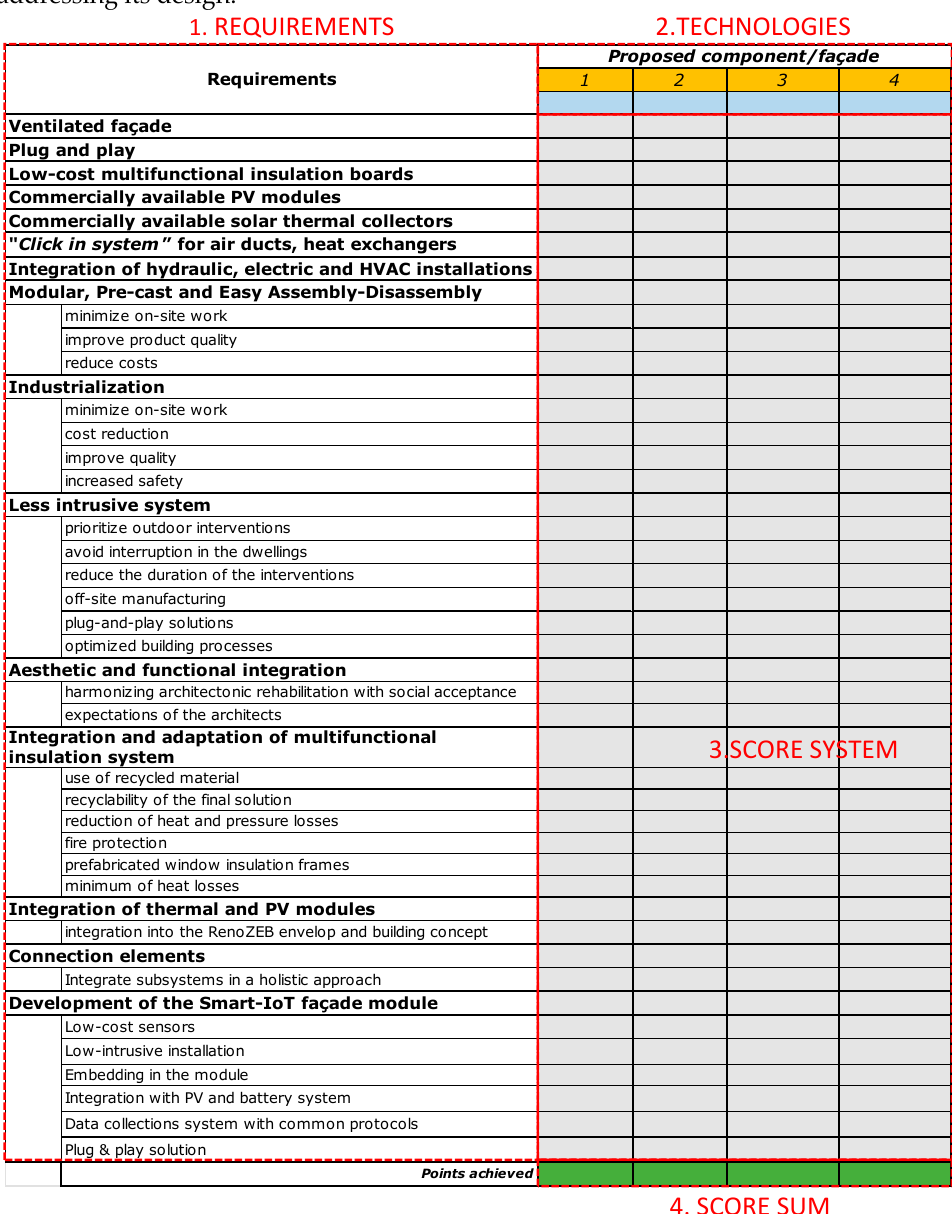
Figure 1. Multi-criteria decision matrix